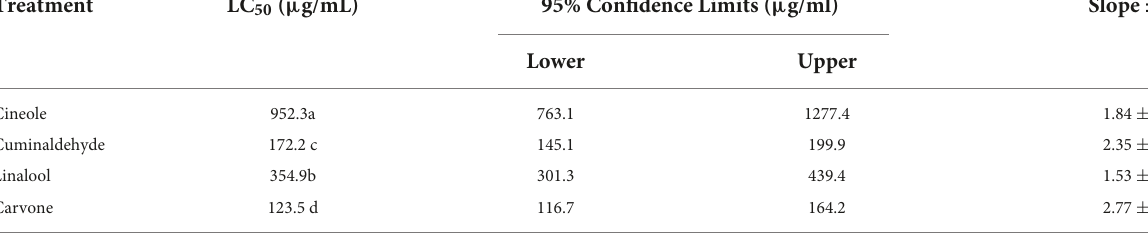
TABLE 2 Effect of the used compounds on the mortality.